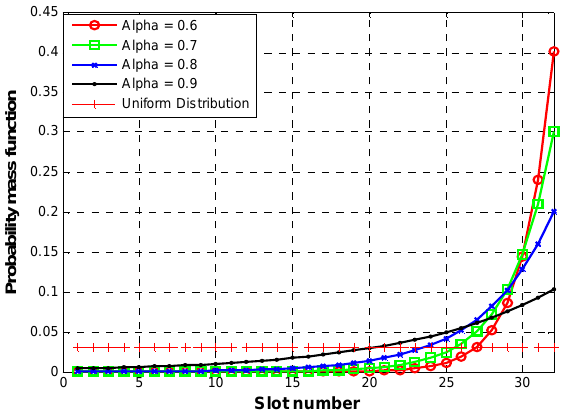
Figure 5. Difference between uniform and truncated geometric